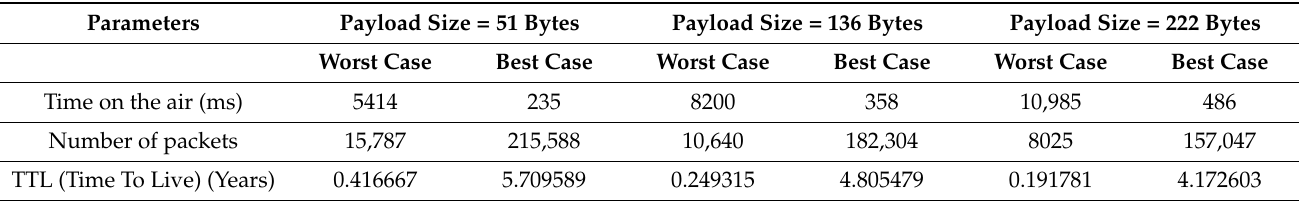
Table 11. Battery lifetime in the case of [19] Defualt Option (DO) case for different message sizes (94 bytes overhead due to security).